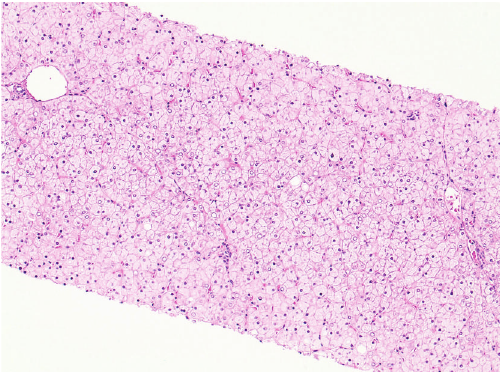
Figure 2: Liver Biopsy. Diffusely pale and swollen hepatocytes with numerous glycogenated nuclei. There is no architectural distortion, significant inflammation, or large droplet